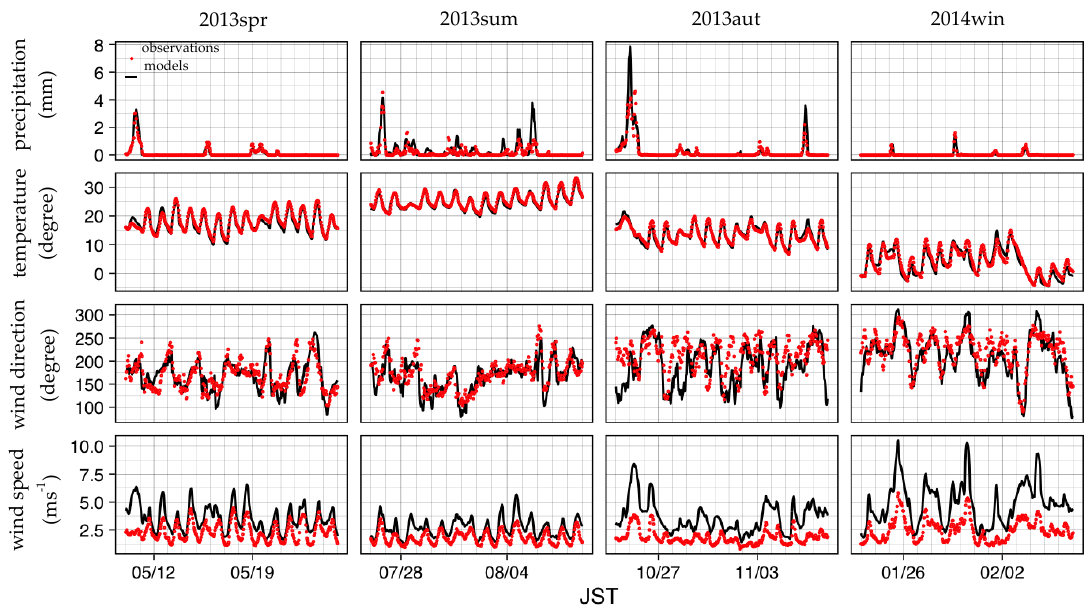
Figure 3. Spatially averaged precipitation, temperature, wind direction, and wind speed over the four seasons. These results are based on hourly observed values and simulated at all JMA stations for d04.